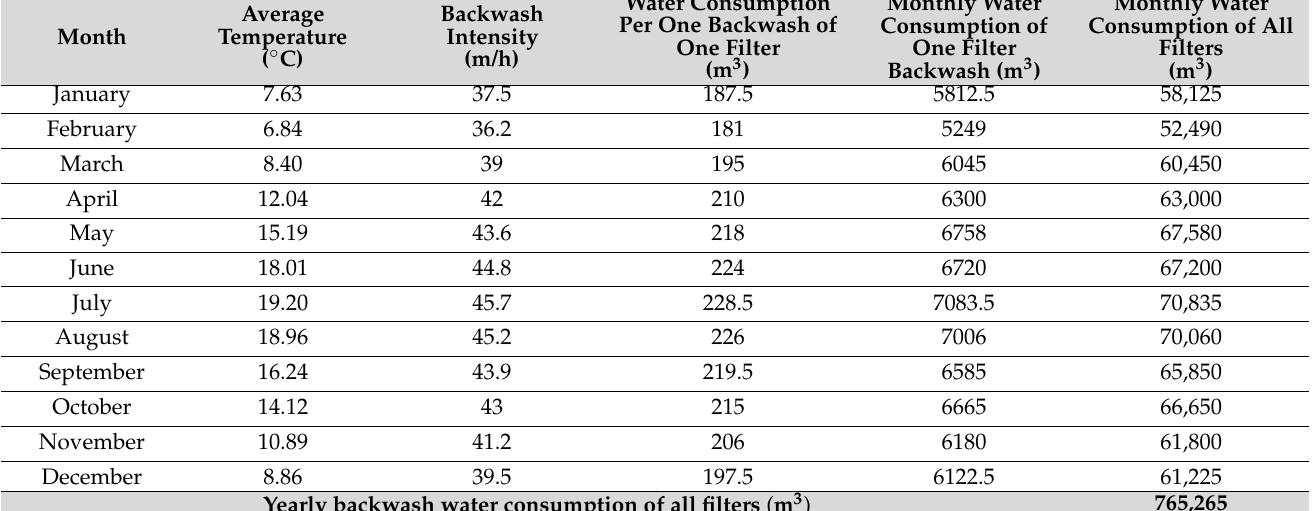
Table 3. Amount of water used for the backwash of rapid filters with monthly adjustment of backwash intensity.